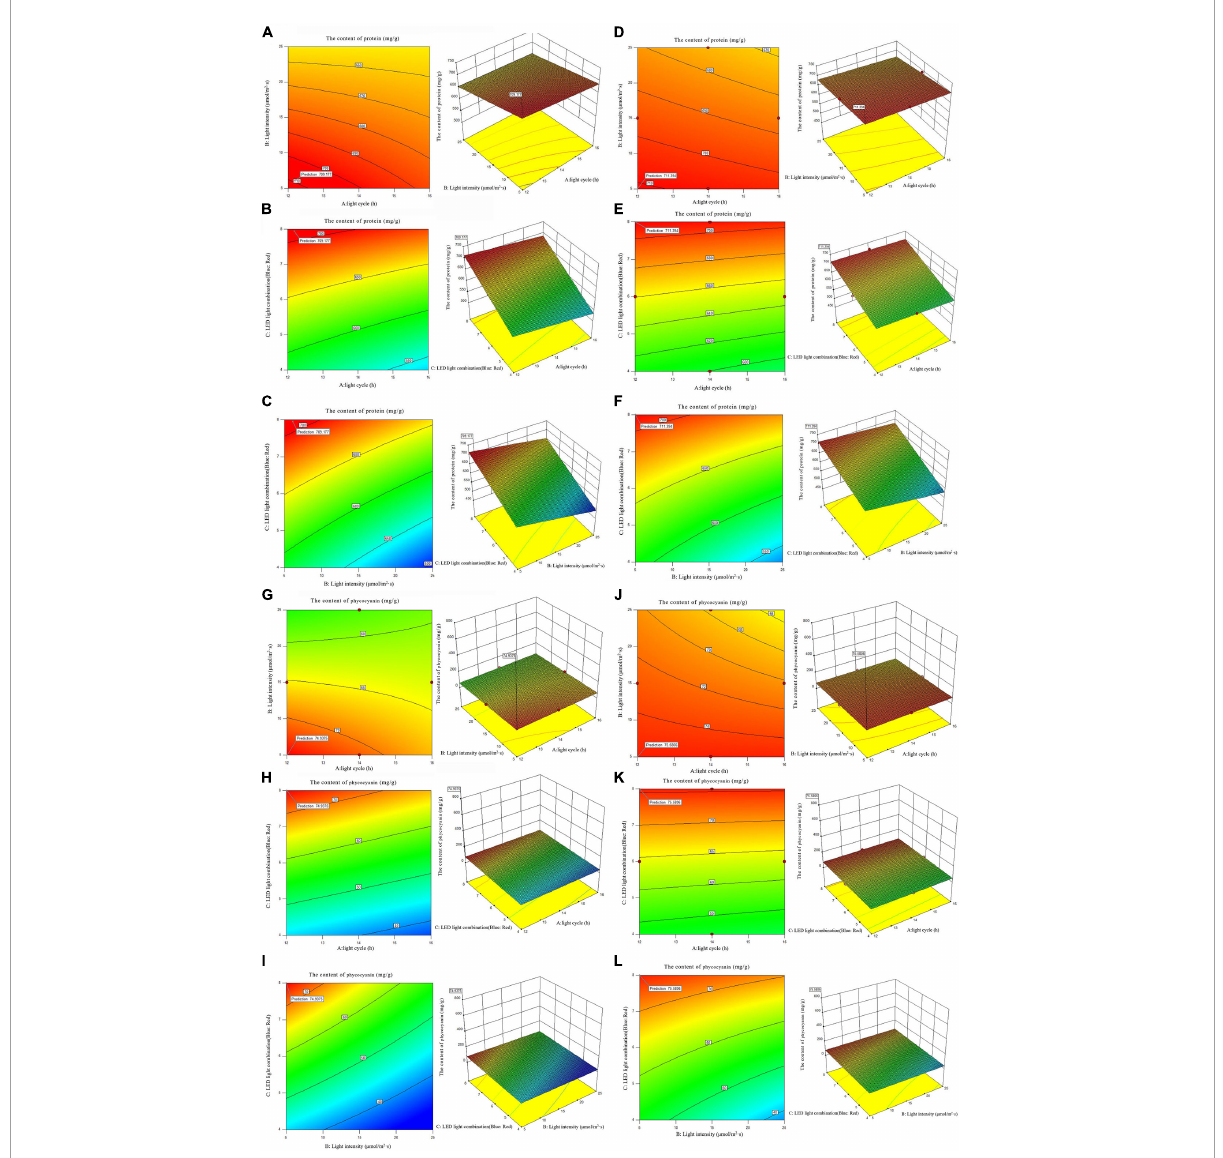
FIGURE6 2D contour diagram and 3D surface diagram of protein and phycocyanin content of Arthrospira platensis OUC623 and A. platensis OUC793. (A) Contour diagram and response surface diagram of protein content of 623 with light time (12, 14, and 16 h) and light intensity (5, 15, and 25 µ mol/m 2 s) under the light of blue6: red1. (B) Contour diagram and response surface diagram of protein content of 623 with light time (12, 14, and 16 h) and red and blue light combination (blue: red = 4:1, 6:1, 8:1) under light intensity of 15 µ mol/m 2 s. (C) Contour diagram and response surface diagram of protein content of 623 with red and blue light combination (blue: red = 4:1, 6:1, 8:1) and light intensity (5, 15, and 25 µ mol/m 2 s) under the light cycle of L14:D10. (D) Contour diagram and response surface diagram of protein content of 793 with light time (12, 14, and 16 h) and light intensity (5, 15, and 25 µ mol/m 2 s) under the light of blue6: red1. (E) Contour diagram and response surface diagram of protein content of 793 with light time (12, 14, and 16 h) and red and blue light combination (blue: red = 4:1, 6:1, 8:1) under light intensity of 15 µ mol/m 2 s. (F) Contour diagram and response surface diagram of protein content of 793 with red and blue light combination (blue: red = 4:1, 6:1, 8:1) and light intensity (5, 15, and 25 µ mol/m 2 s) under the light cycle of L14:D10. (G) Contour diagram and response surface diagram of phycocyanin content of 623 with light time (12, 14, and 16 h) and light intensity (5, 15, and 25 µ mol/m 2 s) under the light of blue6:red1. (H) Contour diagram and response surface diagram of phycocyanin content of 623 with light time (12, 14, and 16 h) and red and blue light combination (blue: red = 4:1, 6:1, 8:1) under light intensity of 15 µ mol/m 2 s. (I) Contour diagram and response surface diagram of phycocyanin content of 623 with red and blue light combination (blue: red = 4:1, 6:1, 8:1) and light intensity (5, 15, and 25 µ mol/m 2 s) under the light cycle of L14:D10. (J) Contour diagram and response surface diagram of phycocyanin content of 793 with light time (12, 14, and 16 h) and light intensity (5, 15, and 25 µ mol/m 2 s) under the light of blue6:red1. (K) Contour diagram and response surface diagram of phycocyanin content of 793 with light time (12, 14, and 16 h) and red and blue light combination (blue: red = 4:1, 6:1, 8:1) under light intensity of 15 µ mol/m 2 s. (L) Contour diagram and response surface diagram of phycocyanin content of 793 with red and blue light combination (blue: red = 4:1, 6:1, 8:1) and light intensity (5, 15, and 25 µ mol/m 2 s) under the light cycle of